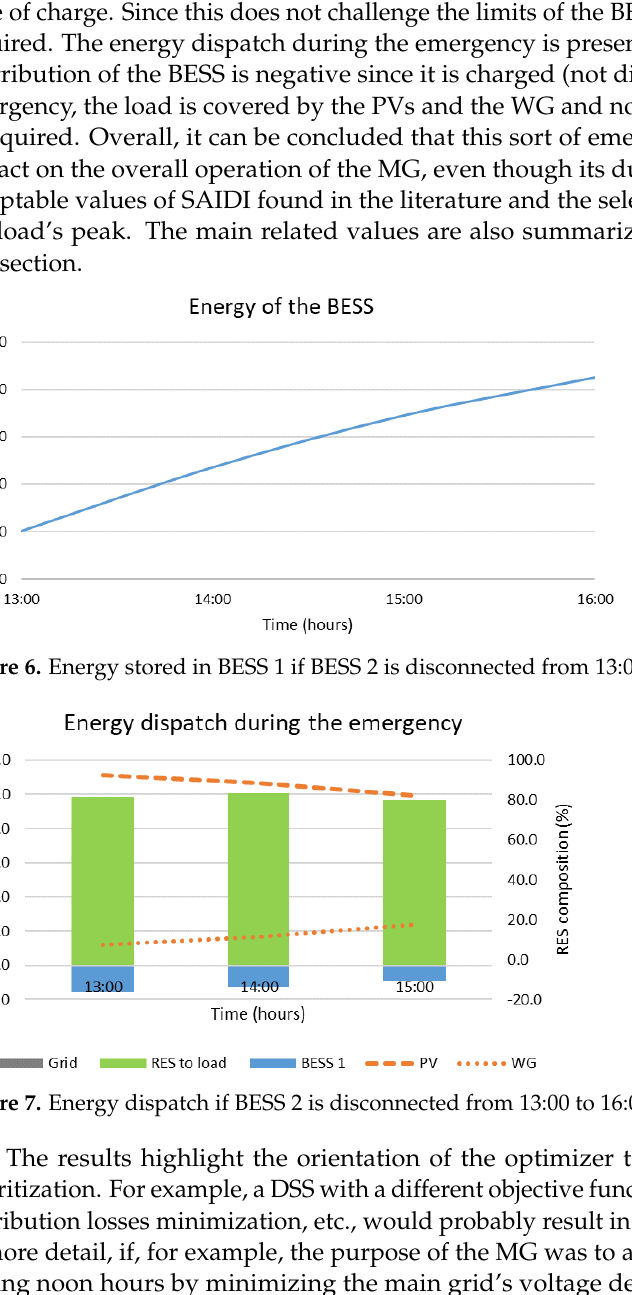
Figure 8 . Energy stored in each BESS for islanded operation from 13:00 to 19:00.